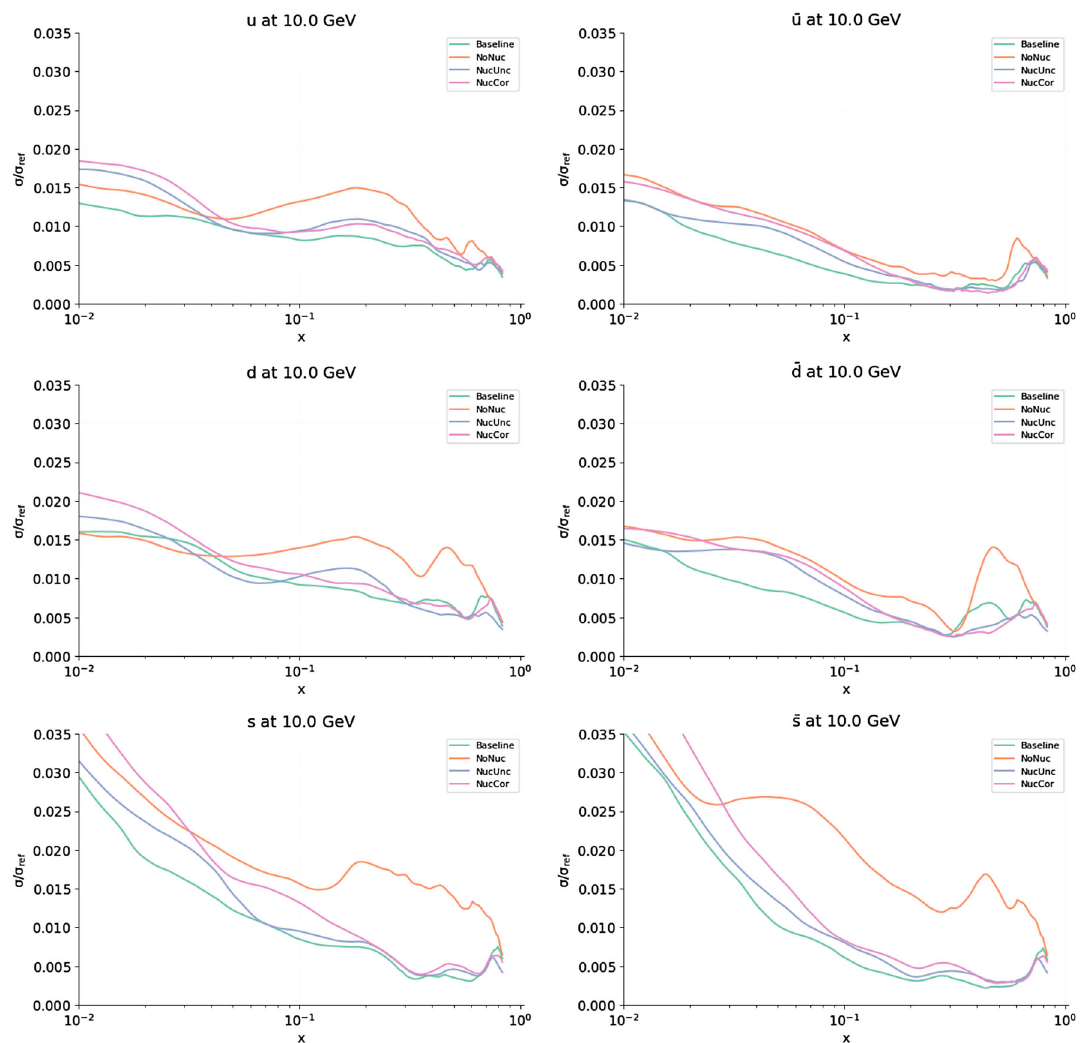
Fig. 12 Comparison of the absolute PDF uncertainty for the light quark and antiquark flavours from the four fits performed in this analysis at Q = 10 GeV